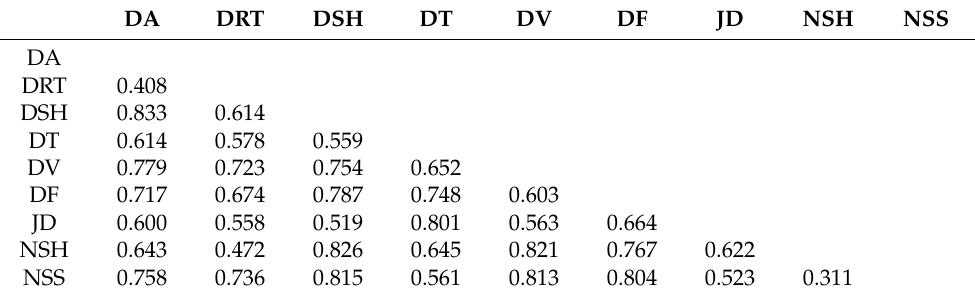
Table 4. Values of heterotrait–monotrait ratio (HTMT).